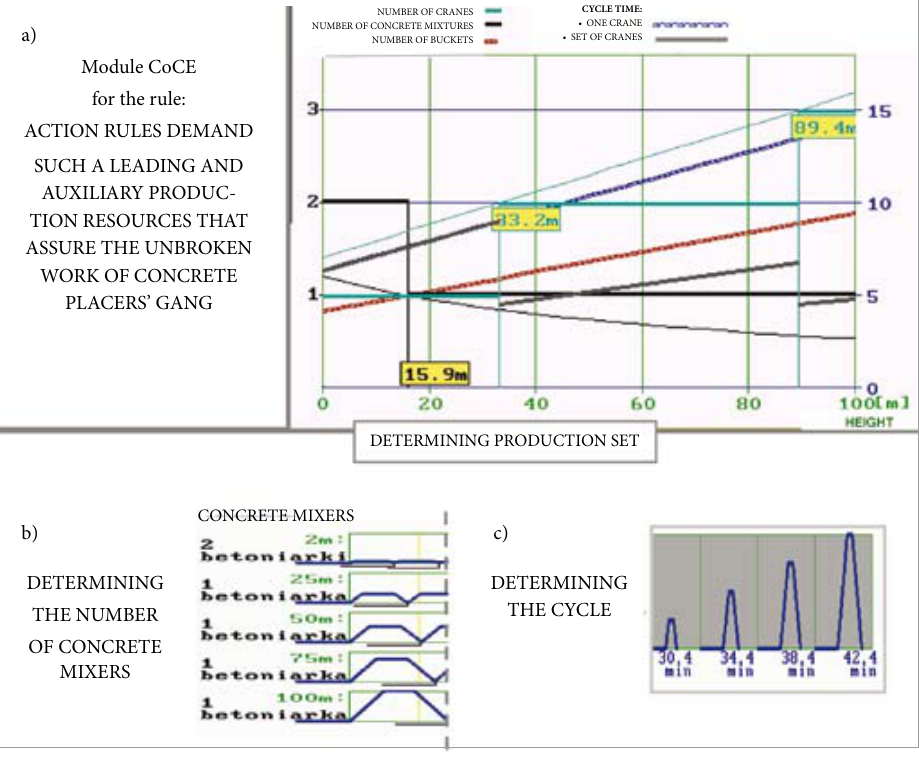
Fig. 7. An exemplary set of machines allowing for uninterrupted work of machines and groups of